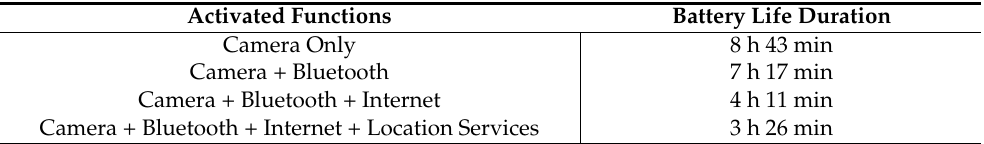
Table 3. Battery life duration evaluation based on activated functions while running the mobile application.